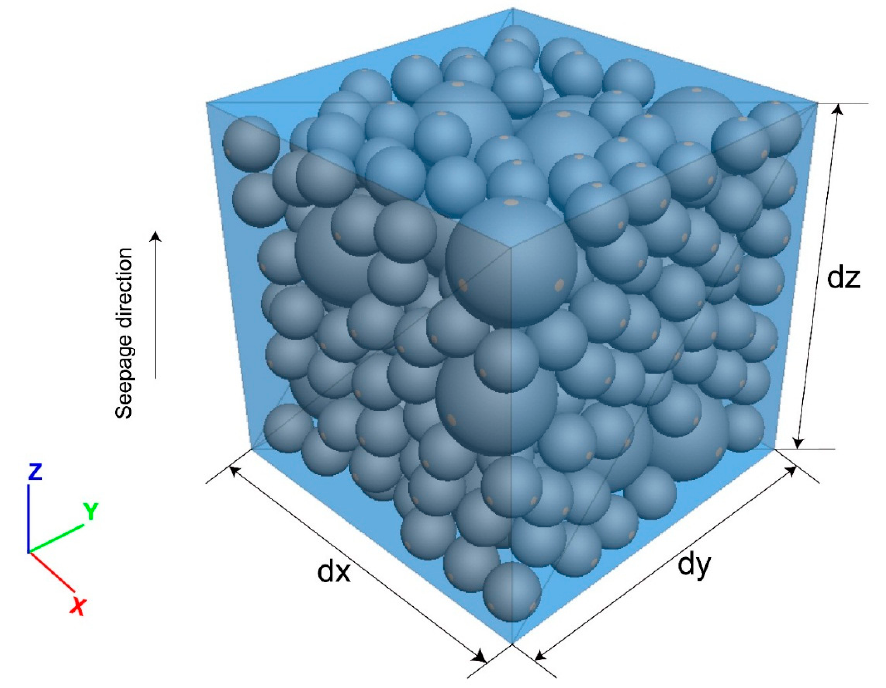
Figure 2. Fluid element diagram.